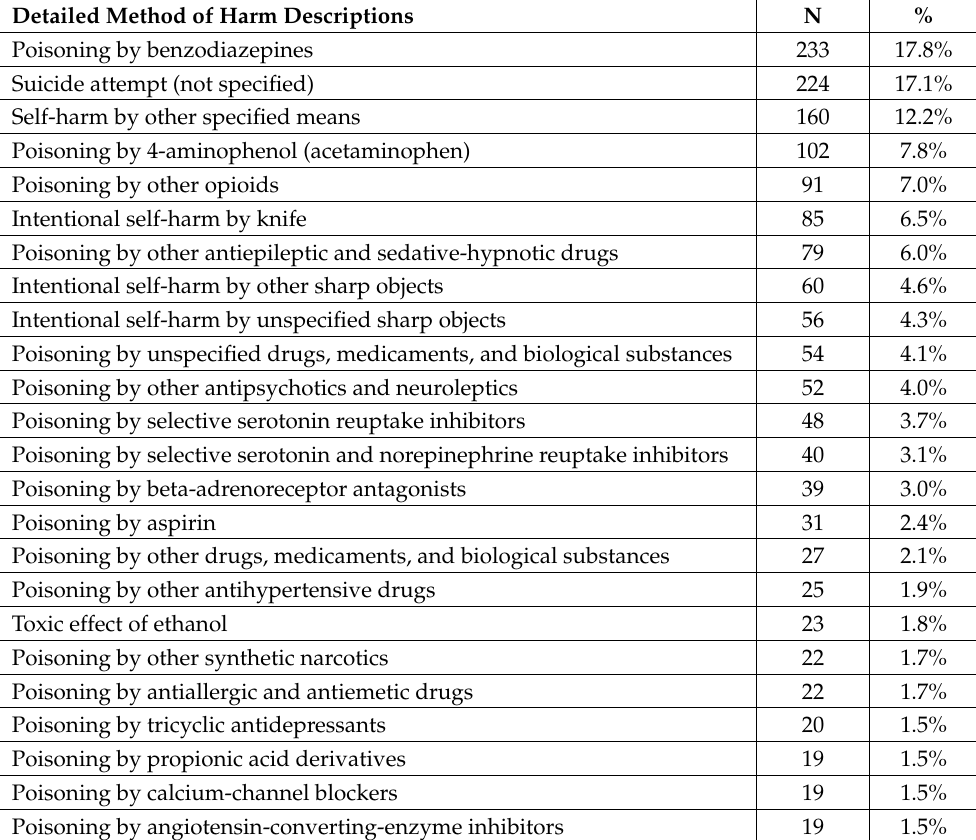
Table 4. Detailed description of methods of harm reported on hospitalizations for suicide attempts in patients with Alzheimer’s disease and related dementias,